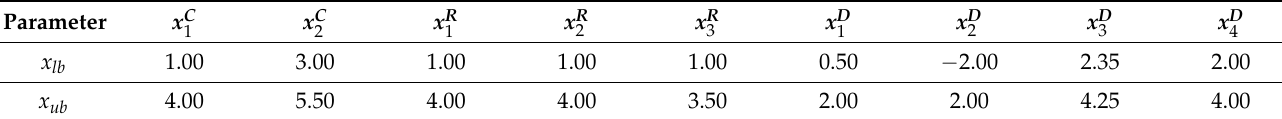
Table 3. Boundaries for each